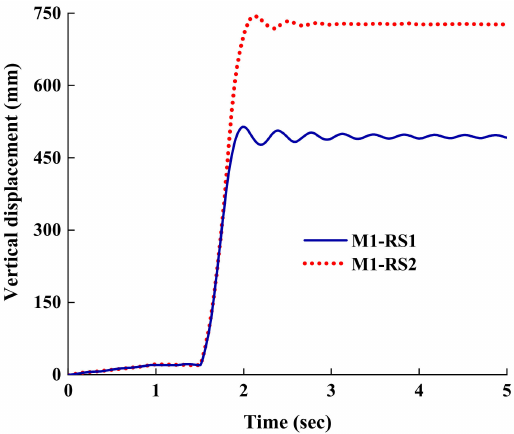
Figure 28. Responses of model M1-RS1 and M1-RS2 subjected to sudden loss of column D5.